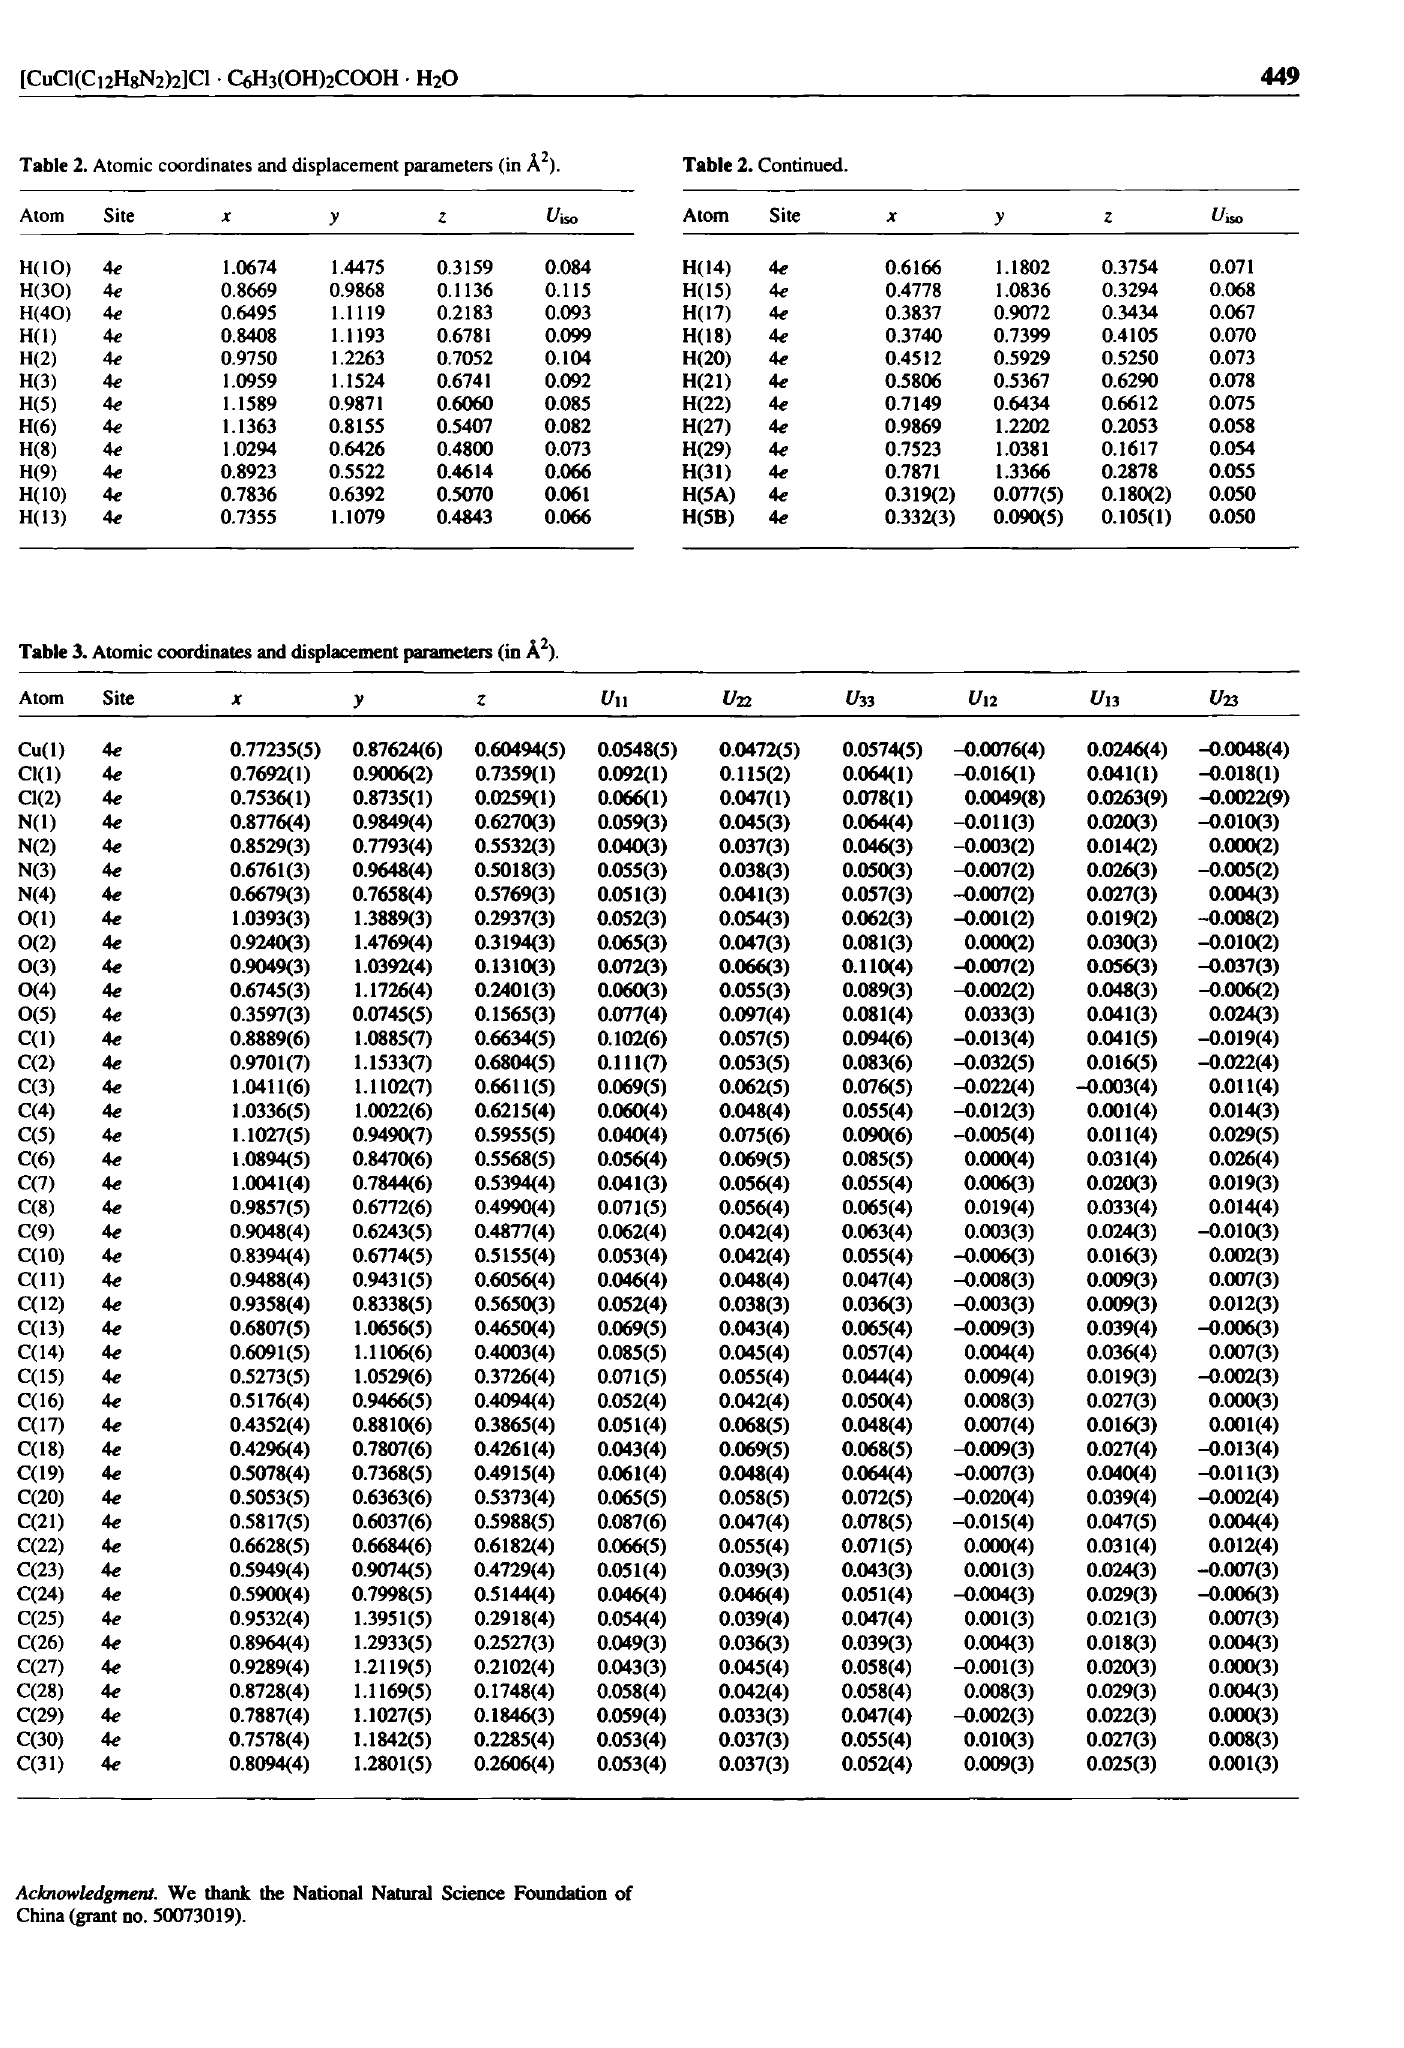
Table 3. Atomic coordinates and displacement parameters (in A 2